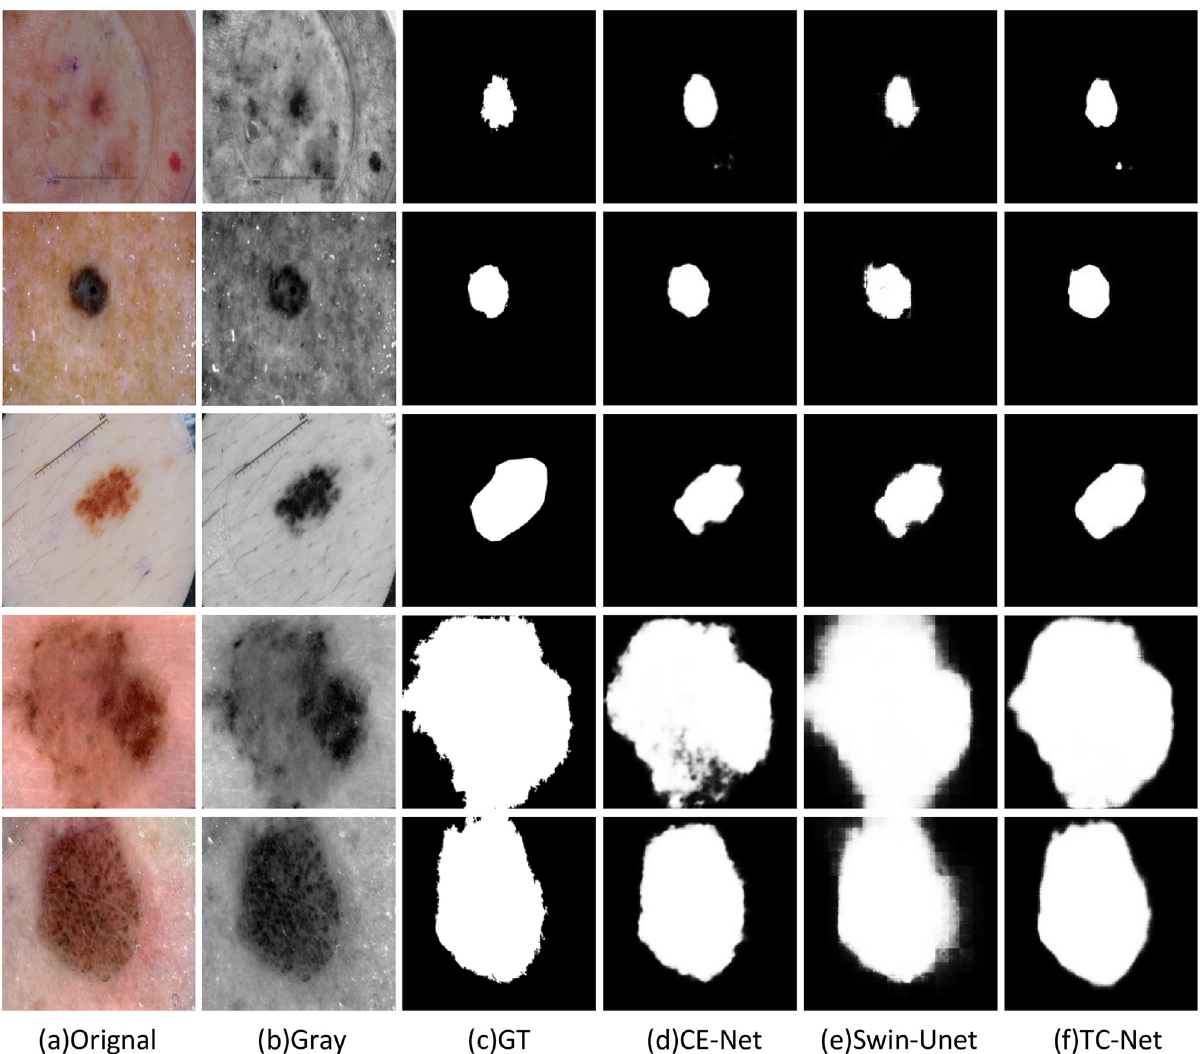
Fig 7. The example on ISIC2018 dataset, (a) original image; (b) Gray image; (c) GT label image; (d) Segmentation image of CE-Net; (e) Segmentation image of Swin-UNet; (f) Segmentation image of TC-Net.